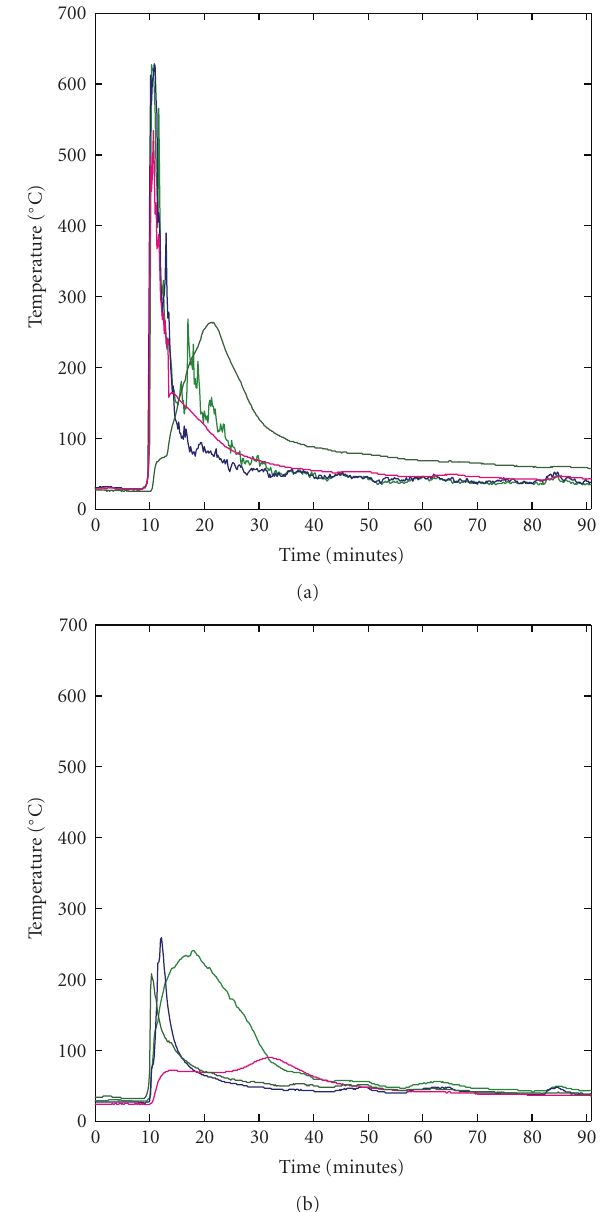
Figure 1: Soil temperatures at the soil surface during a prescribed sand pine scrub fire at Ocala National Forest, Florida on May 10, 1993. Temperatures were recorded with copper-constantan thermocouples placed in vegetated (a) and open (b) microsites. Each microsite location was replicated four